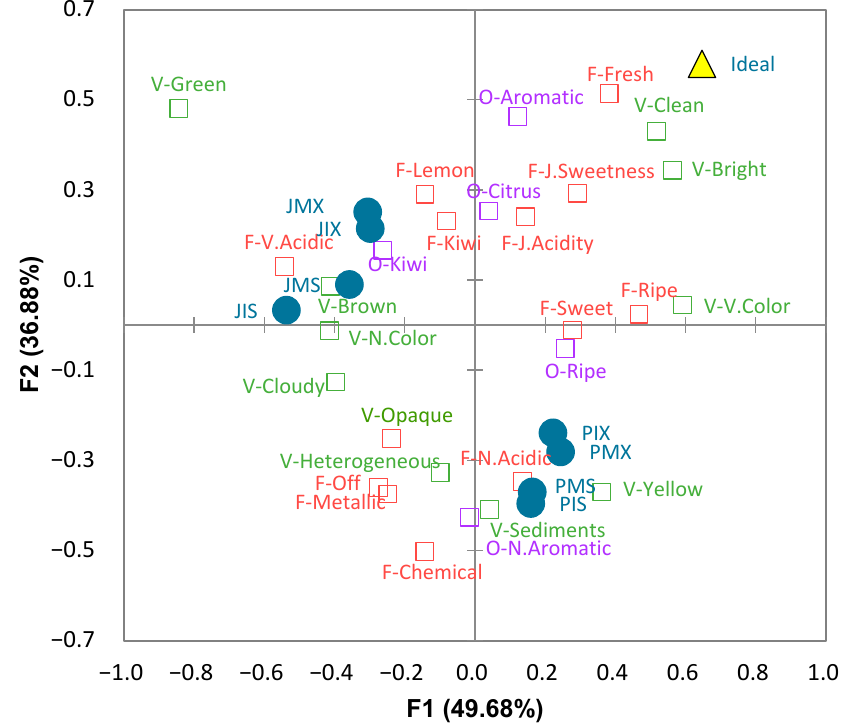
Figure 1. Representation of the lulo beverage samples (JMS, JIS, JMX, JIX, PMS, PIS, PMX, and PIX), attributes and ideal product in the first two dimensions of the multiple correspondence analysis (MCA) of the check-all-that-apply (CATA) counts. P = pulp, J = juice, M = maltodextrin, I = inulin, S = stevia, and X = erythritol + xylitol + stevia.